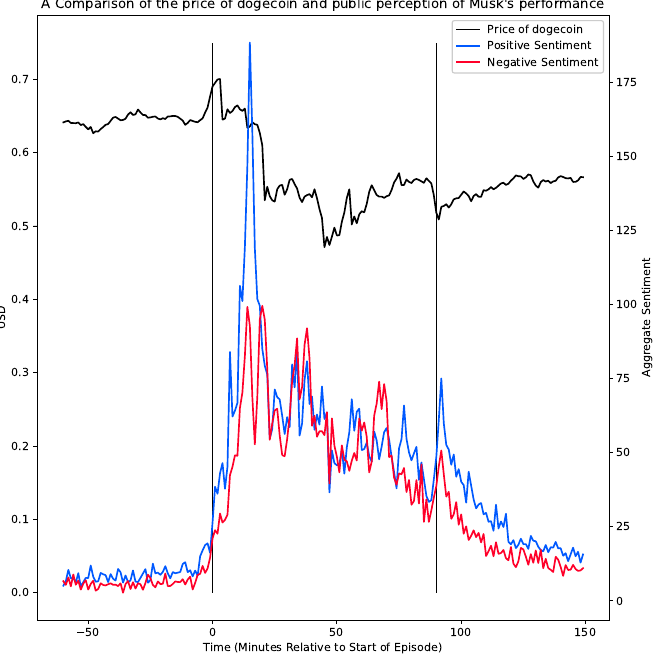
Figure 1. The three time series. The price of Dogecoin is measured in USD on the left hand axis while the positive and negative sentiment scores are measured in aggregate values on the right hand axis. The x axis represents time relative to the start of the episode, and the two vertical black lines denote the start and end of the